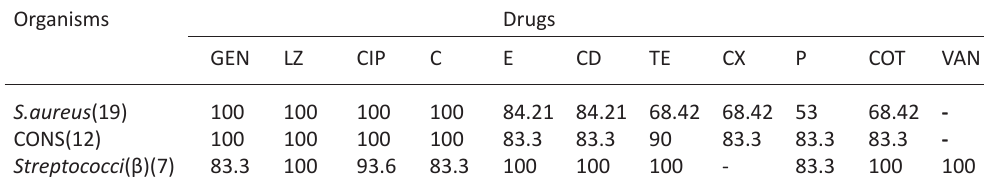
Table 3. Showing the Antibiotic Susceptibility pattern of the Gram Positive Bacteria Organisms